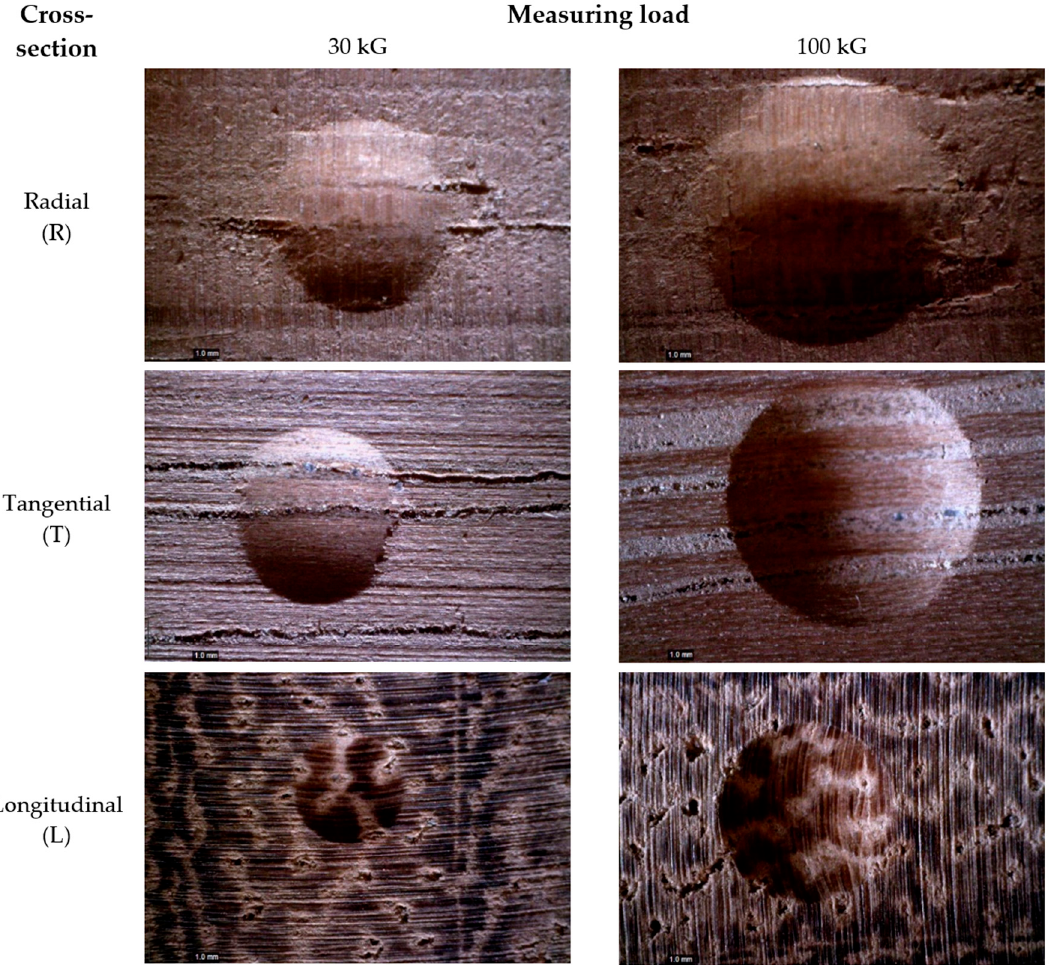
Figure 3. Examples of imprints (iroko wood, 37× magnification).